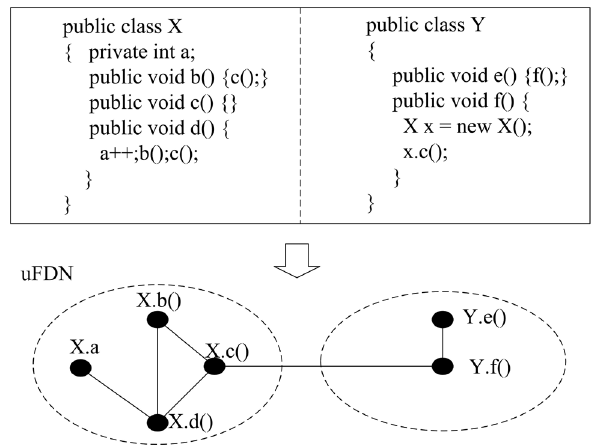
Figure 3. Illustration of